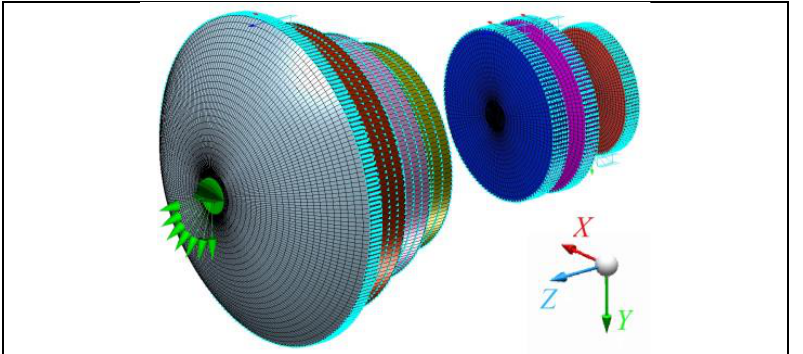
Figure 7. Finite element meshing, boundary condition setting and coordinate system directions, with calculation domain of a hexahedral mesh type and fully fixed constraints on the sides of each lens under gravity without other external forces.